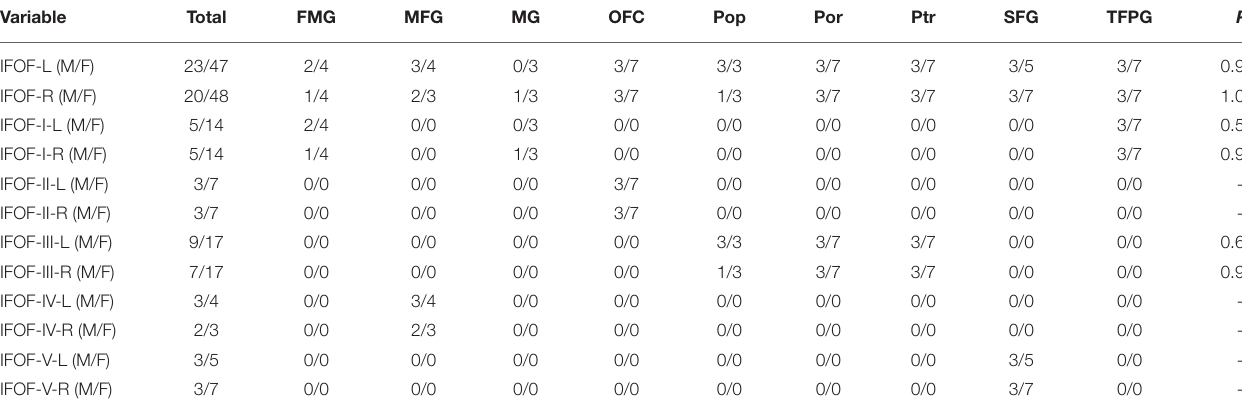
TABLE 3-2 | The terminating distributions of the five subcomponents between males and females.